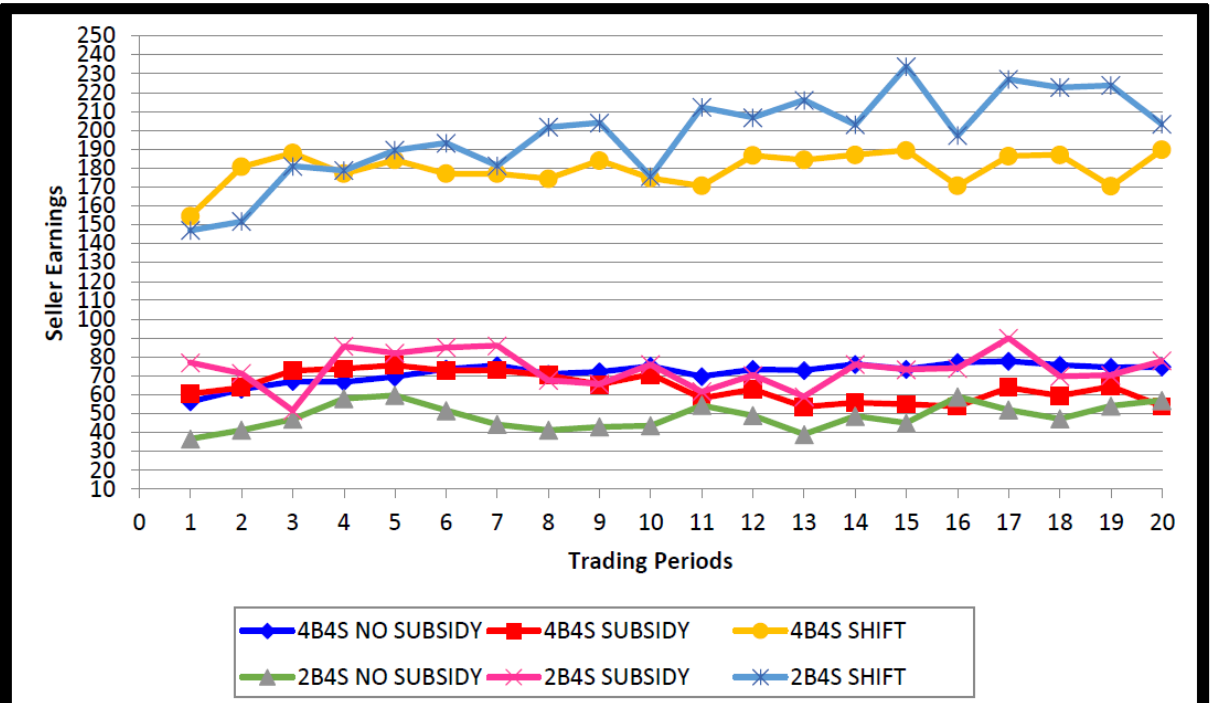
Figure 4. Average seller earnings per trading period by treatment.